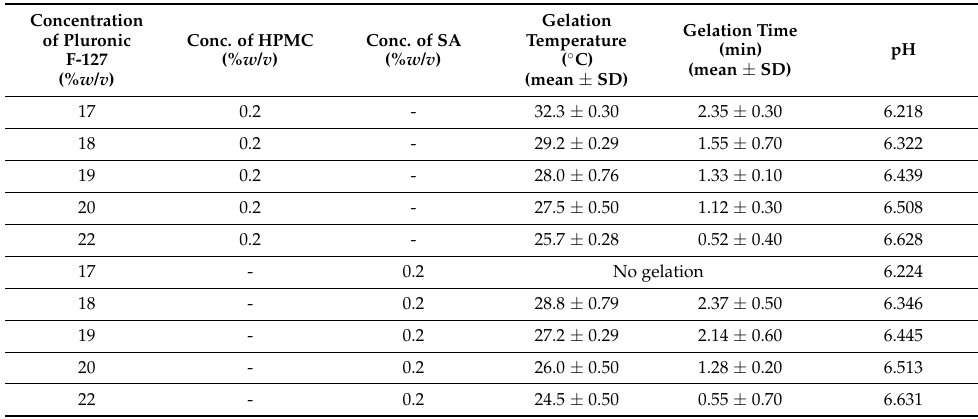
Table 2. Presentation of gelation temperature and gelation time of different combinations of bioadhe- sive polymers and Pluronic